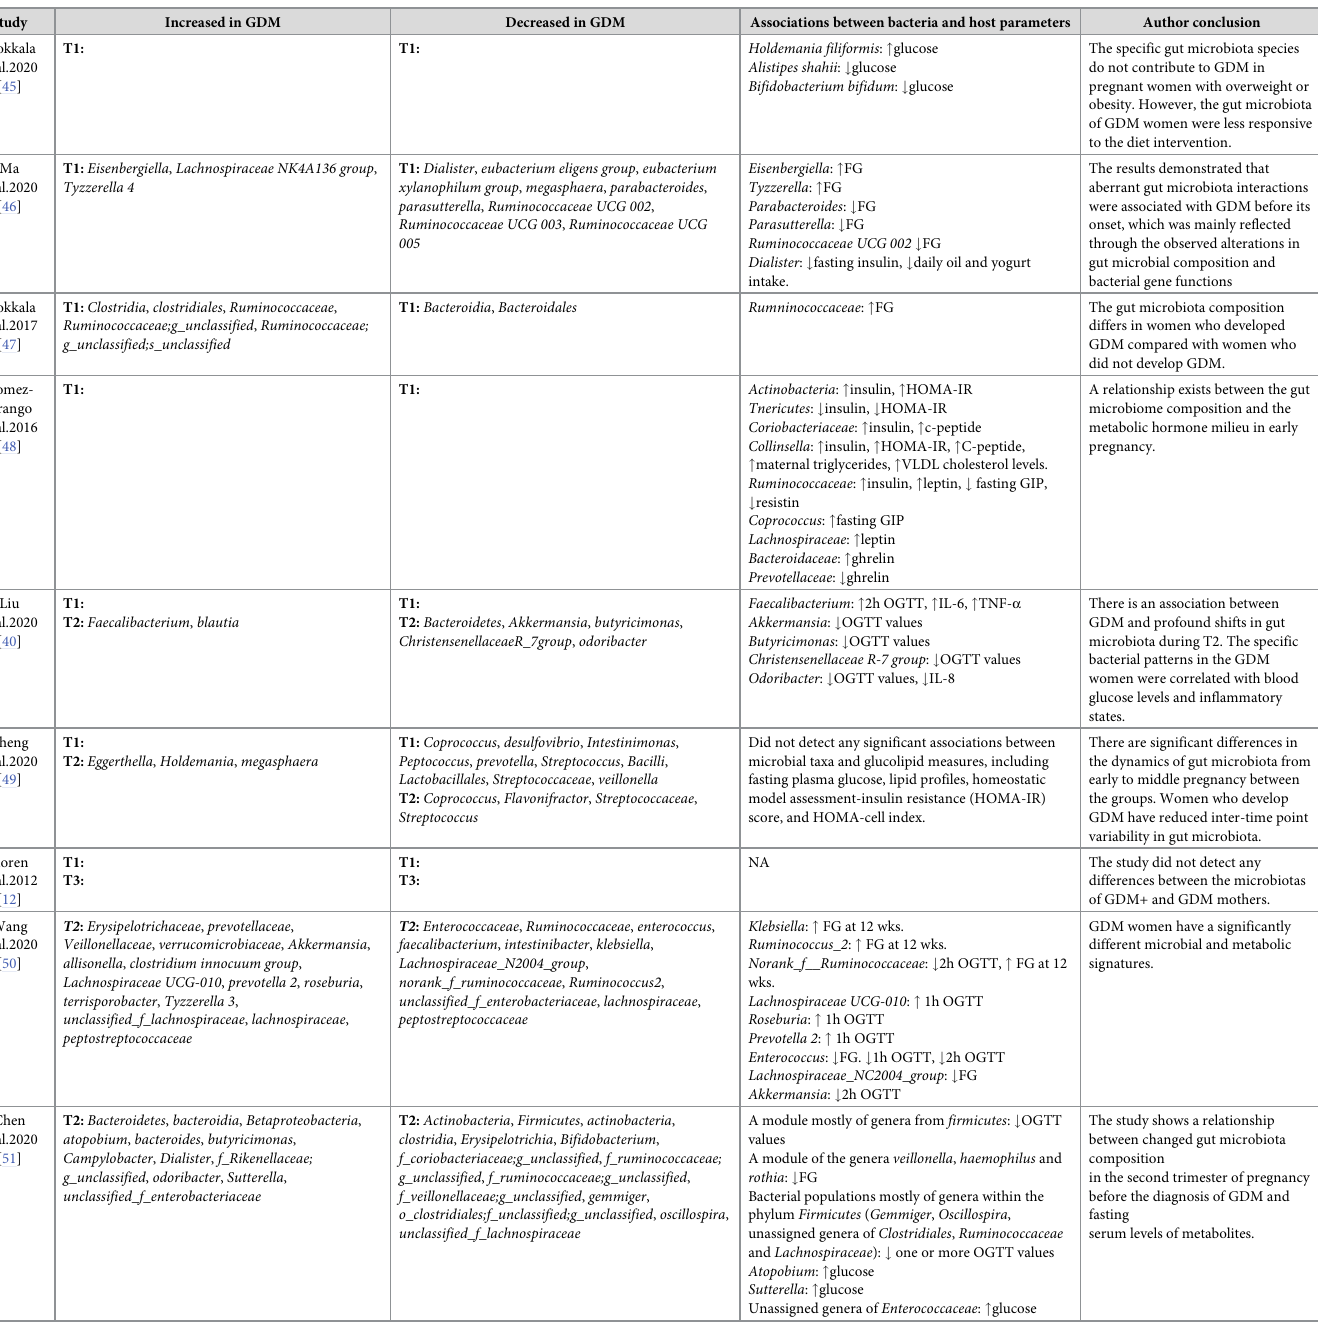
Table 4. Major findings of the included